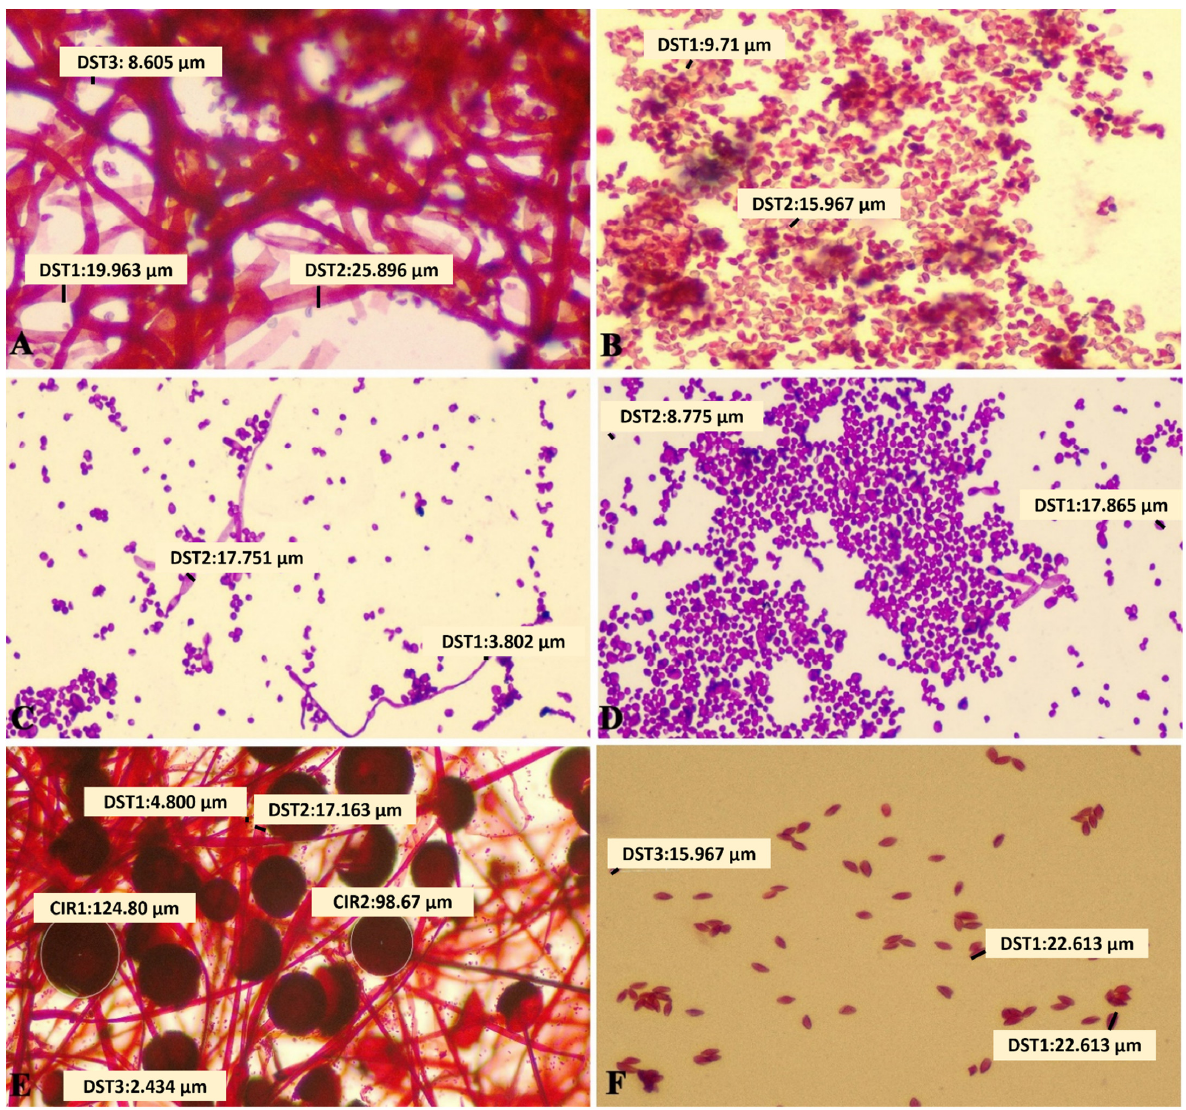
Figure 2. Magnification: ×100 magnification, Safranin–O Stain. Morphometric analysis exhibiting measurements obtained using Gryphax image analysis software. Aspergillus Flavus : ( A ) hyphae; ( B ) spores. Candida albicans : ( C ) hyphae and spores; ( D ) spores and germ tube formation. Rhizopus Oryzae : ( E ) hyphae and fruiting bodies; ( F ) spores. (White calibrations represent measurement). Table 8. Morphometric analysis of mean size of the spores/hyphae/fruiting body of 50 microscopic fields.